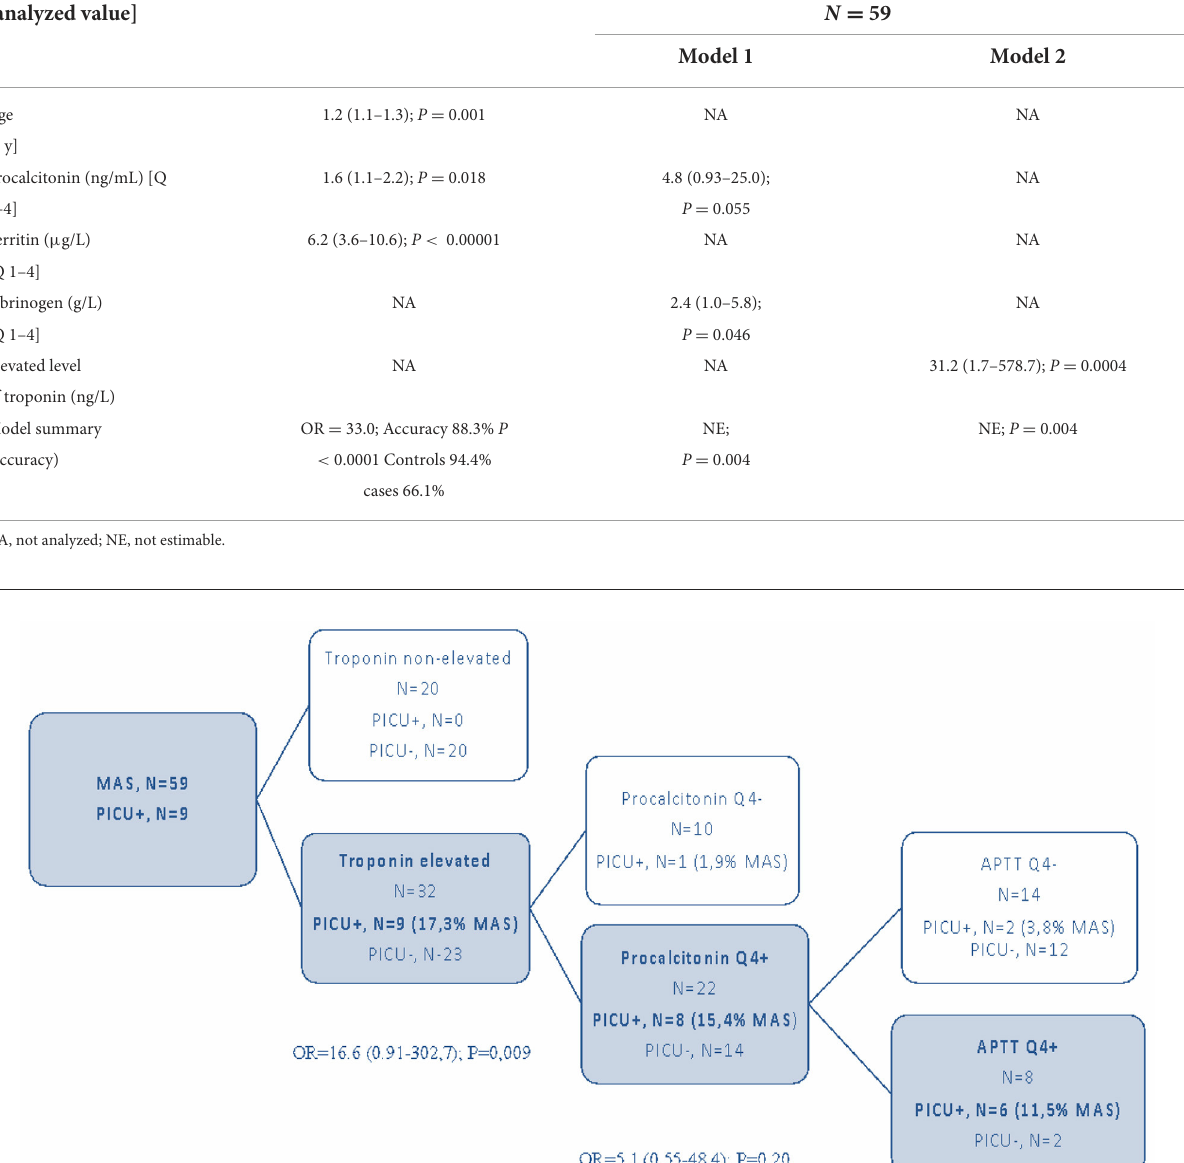
TABLE 2 Multivariate analysis of the association between laboratory findings on hospital admission and the presence of macrophage activation syndrome (MAS) and MAS requiring pediatric intensive care unit (PICU) hospitalization (MAS–PICU) in 274 patients meeting MIS–C criteria. Parameter